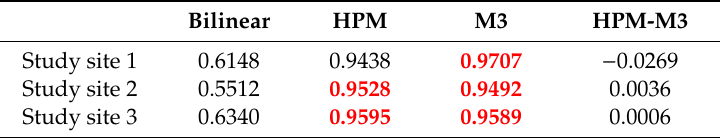
Table 7. Spatial subset Q 2 n values derived considering the four Sentinel-2 10 m sharpened bands (Table 1) together ( n = 4). The highest Q 2 n value (least distortion) for each study site is shown in red bold font, and if values are within two decimal places (i.e., | HPM-M3 | < 0.01), then both are shown in red bold.